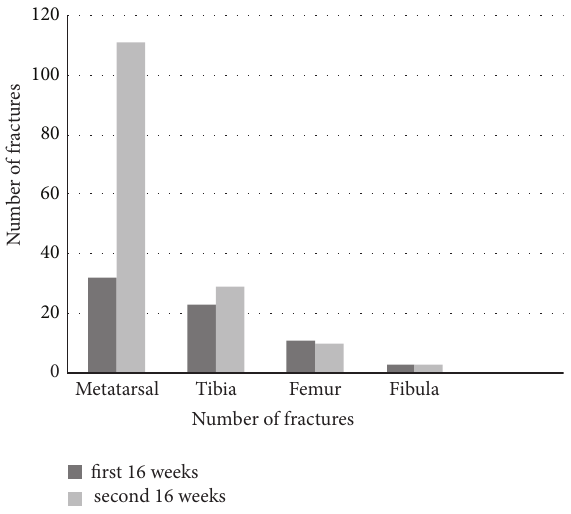
Figure 2: (Group A) Rehabilitation period from injury (Group B). Time in program for regaining fitness and military skills up to allow return to training at their preinjury